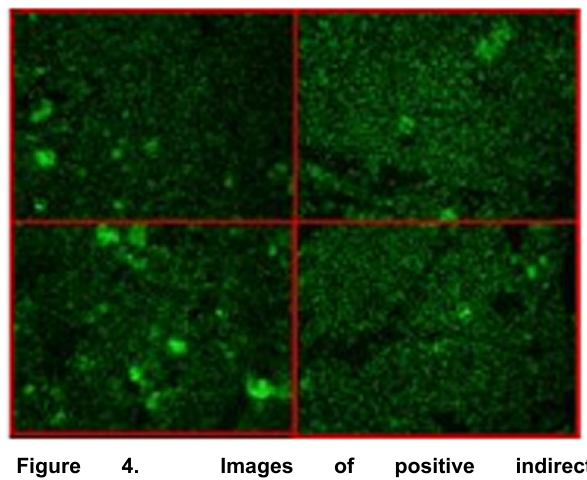
Figure 4. Images of positive indirect immunofluorescence